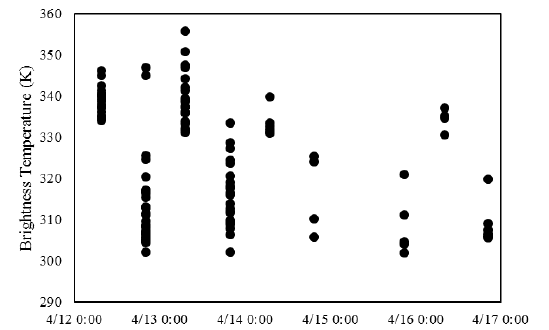
Figure 9 . Fire pixels in terms of brightness temperature (K) in